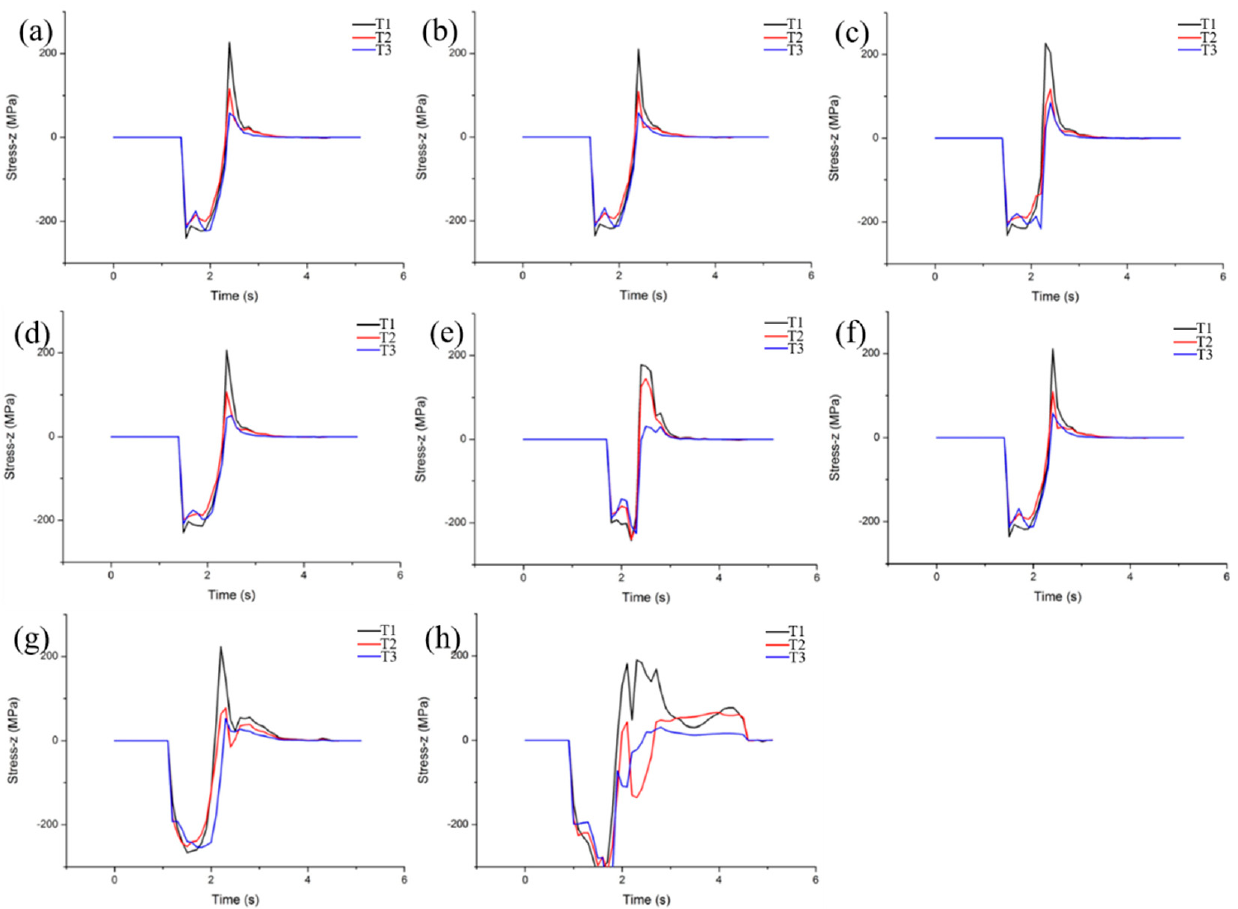
Figure 8. The additive stress distribution along ND direction at set point at different rolling temperatures and reduction: ( a ) 1300 °C, ( b ) 1400 °C, ( c ) 1500 °C, ( d ) 1600 °C, ( e ) 10%, ( f ) 20%, ( g ) 30% and ( h ) 40%.